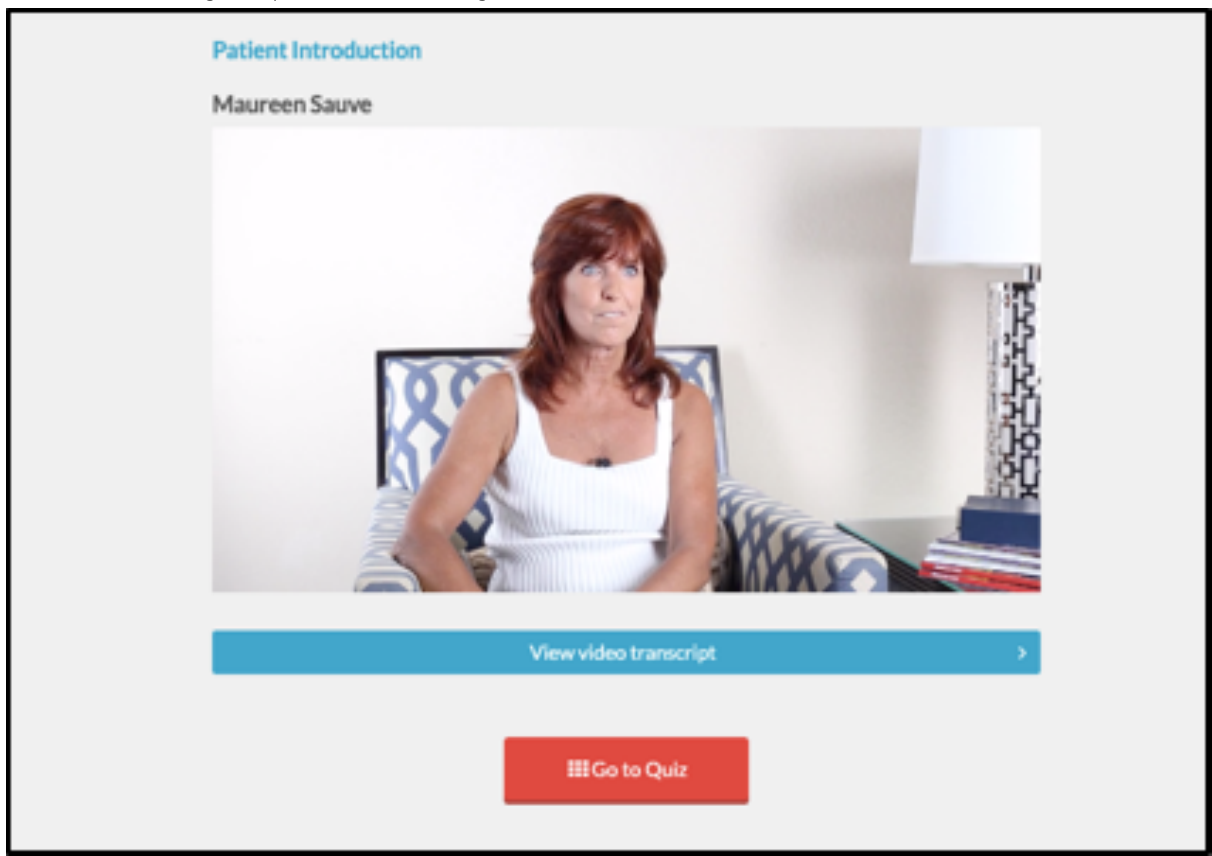
Figure 3. Patient discussing her experience with